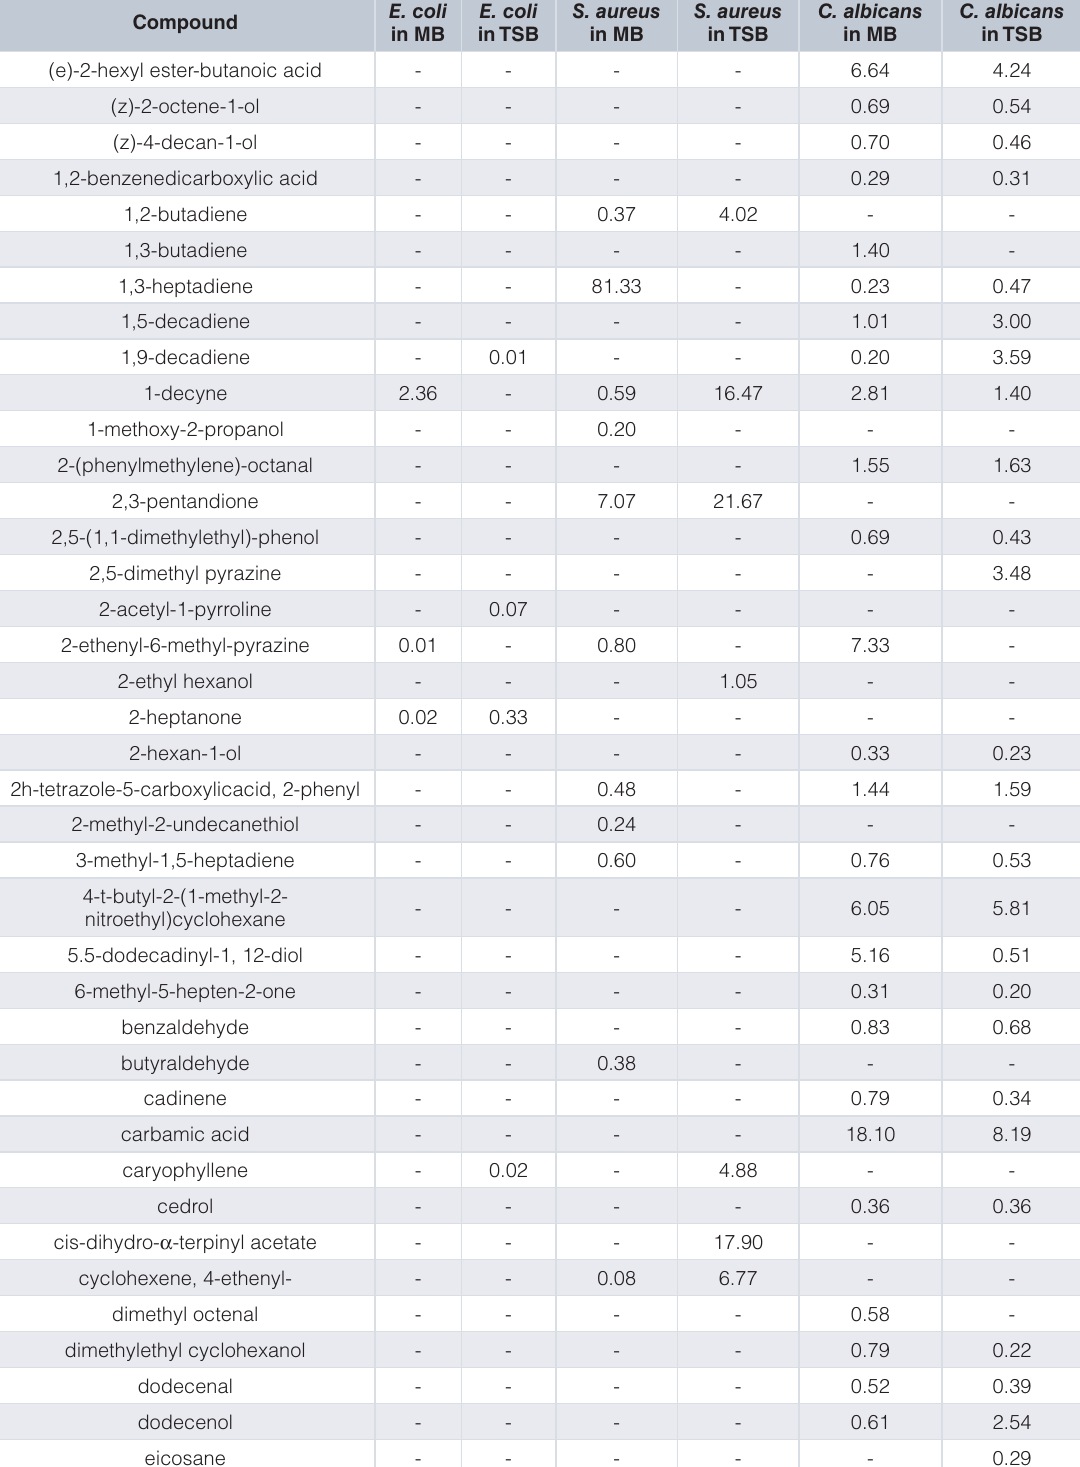
Table 2. The identified VOCs for E. coli , S. aureus and C. albicans, and the percentage of the total area that their average peak covered (peak area %), after 4 hours in MB and TSB media. In total, 9 types of ��Cs by E. coli, 19 types by S. aureus and 4� types by C. albicans were generated in this